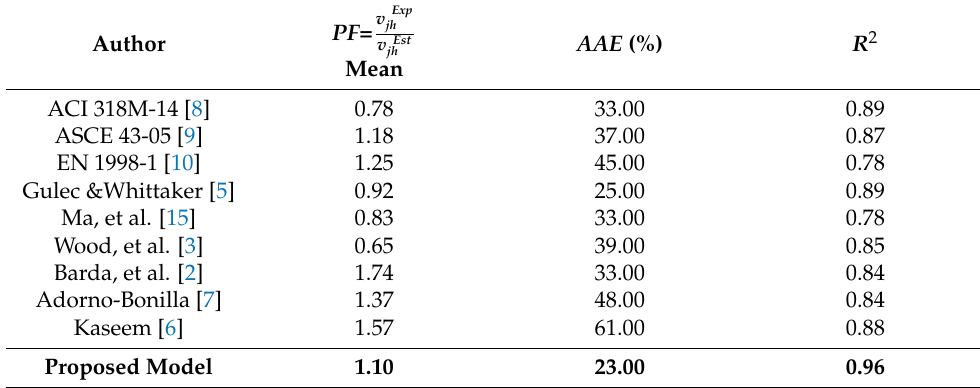
Table 3. Statistical analysis of shear strength prediction models of Squat